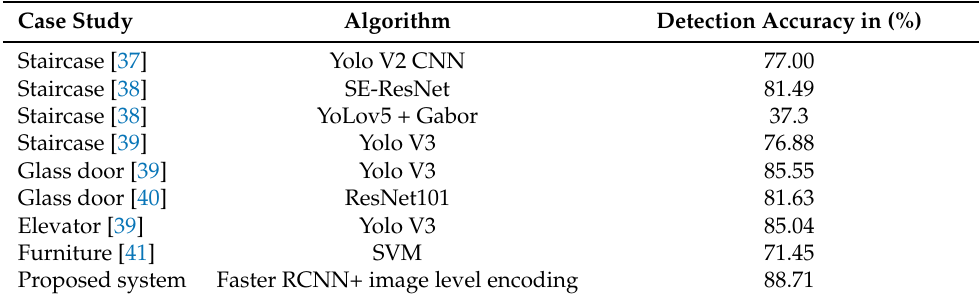
Table 3. Comparison with other defect detection